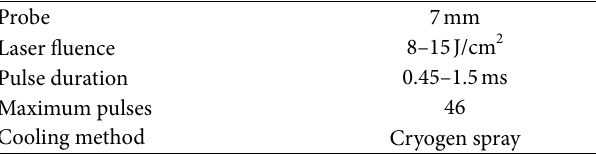
Table 1: Laser parameters used to treat our